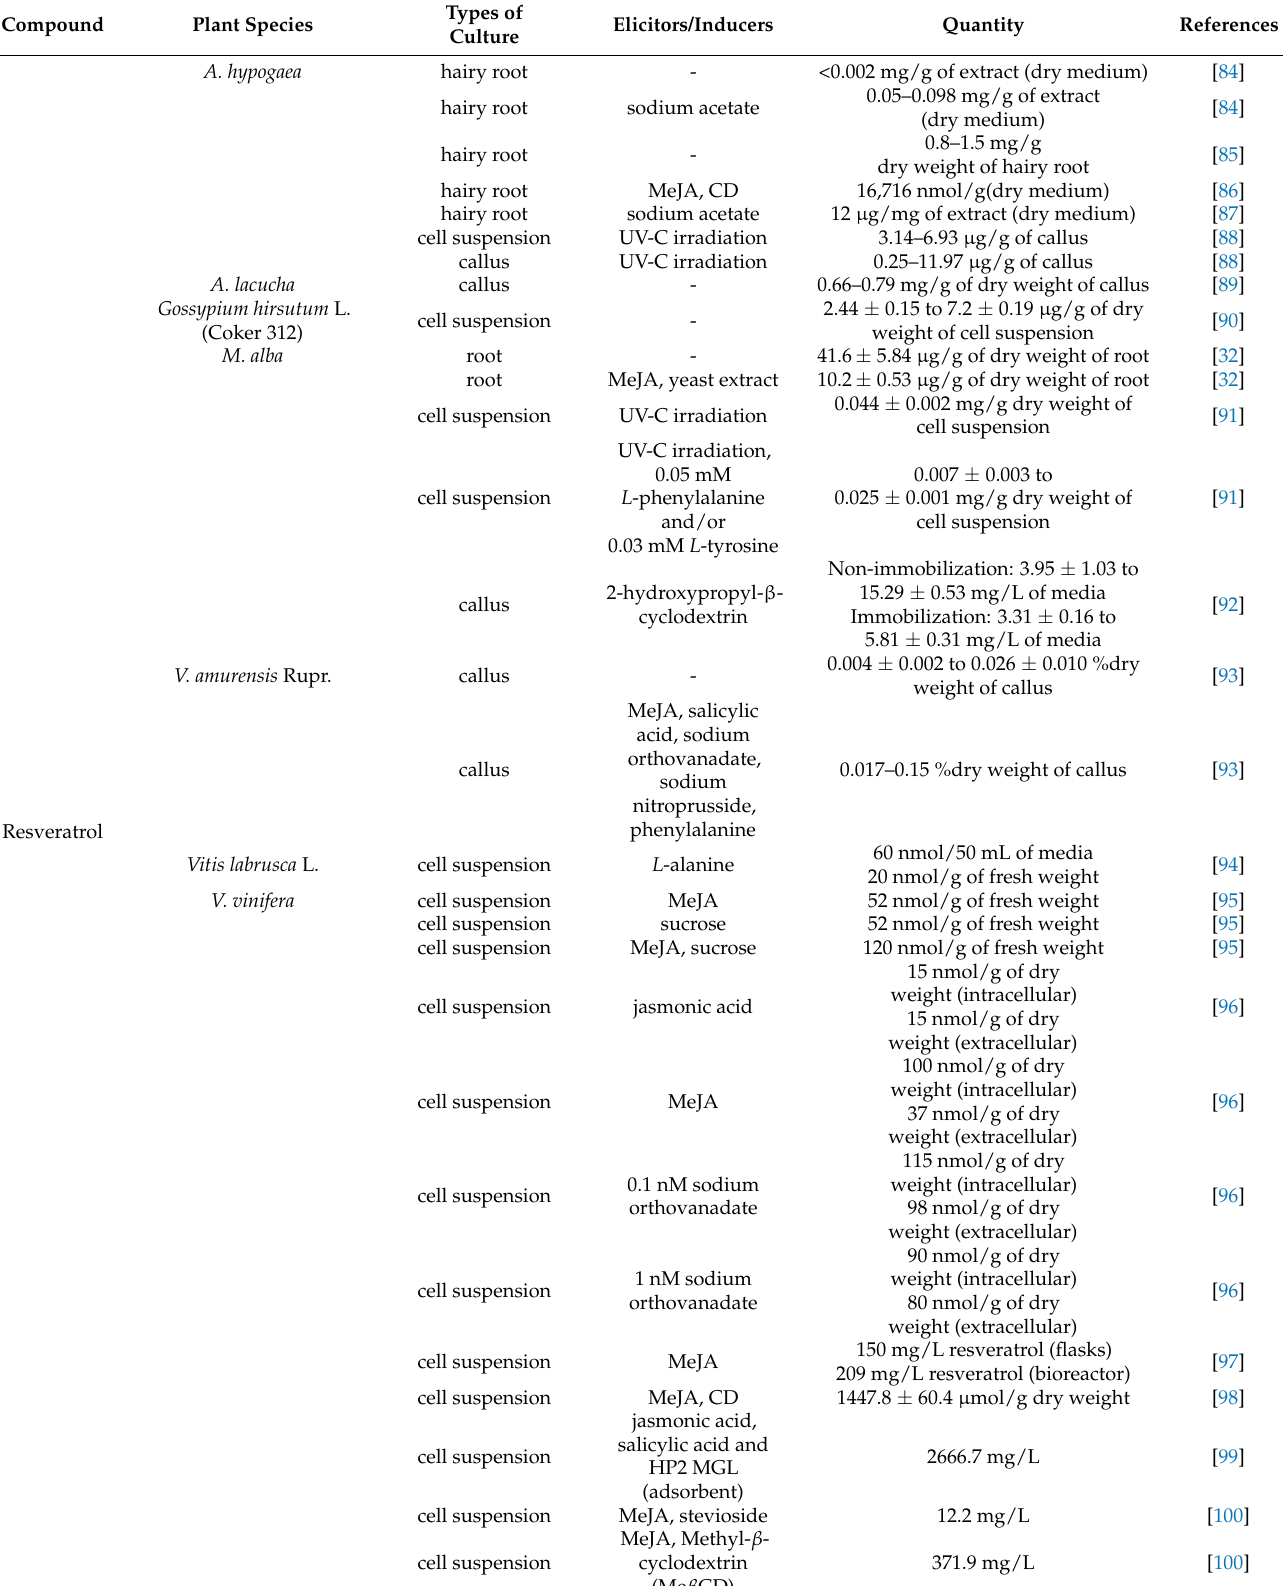
Table 4. List of plant cell cultures for stilbenoids